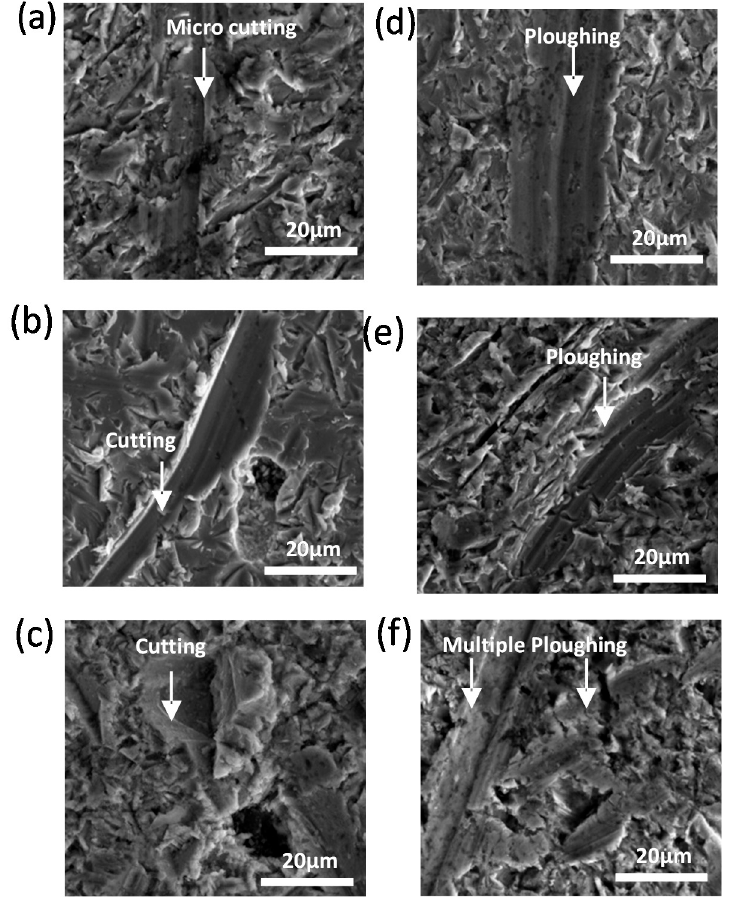
Figure 7. SEM micrographs of 40 m/s at 30° for ( a ) 10 s, ( b ) 300 s, and ( c ) 600 s, and at 90° for ( d ) 10 s, ( e ) 300 s, and ( f ) 600 s.